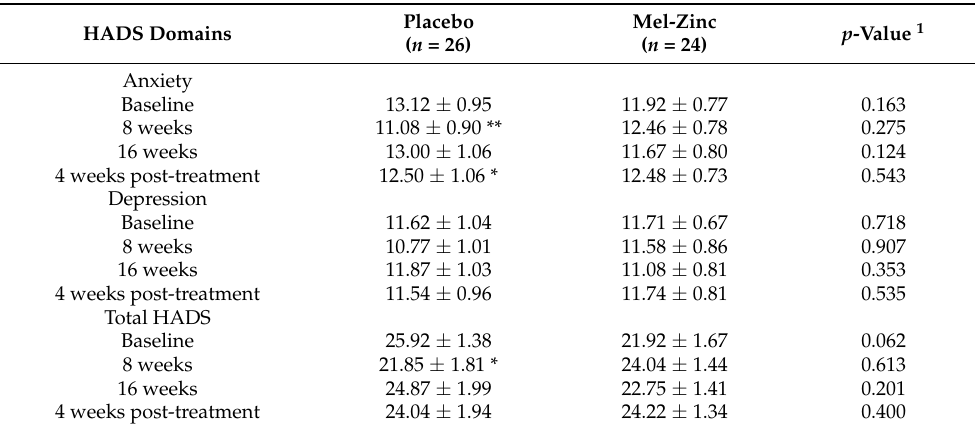
Table 4. Anxiety and Depression scores (HADS questionnaire) of the participants who completed the final assessment.